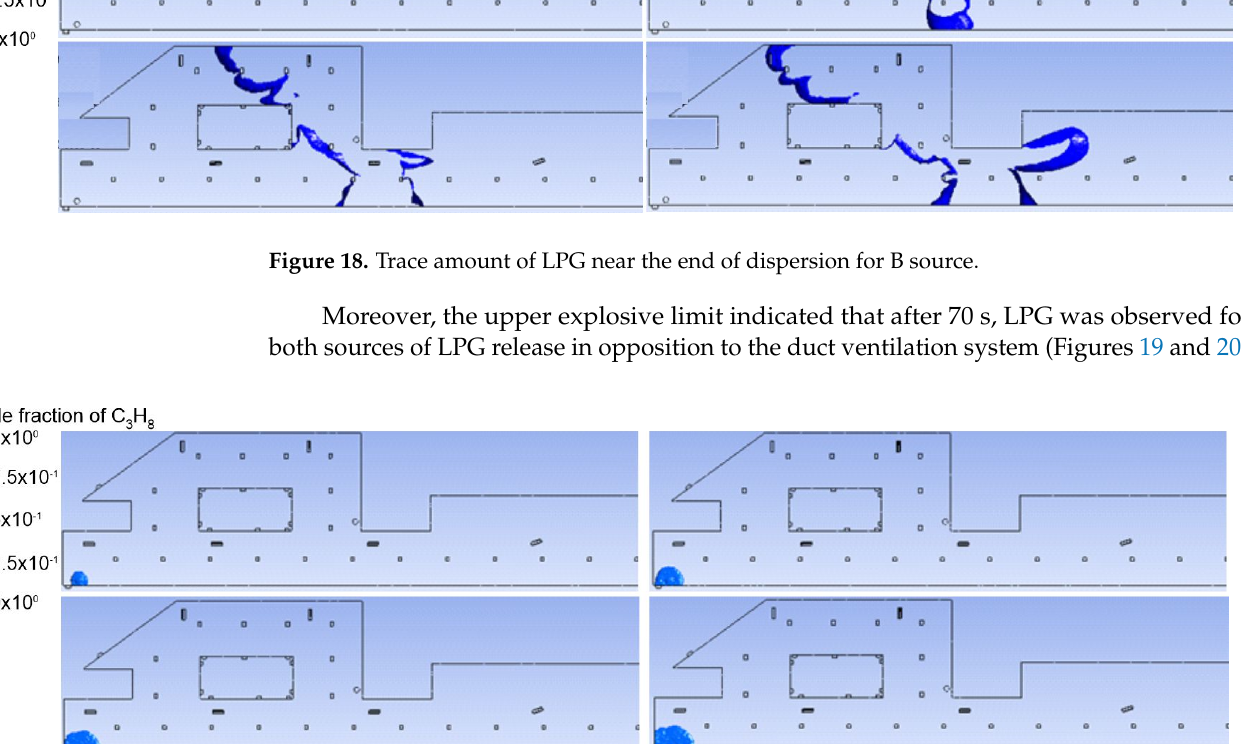
Figure 19. Upper explosive limit of LPG dispersion for A source for the following time steps 20 s, 35 s, 55 s and 70 s.